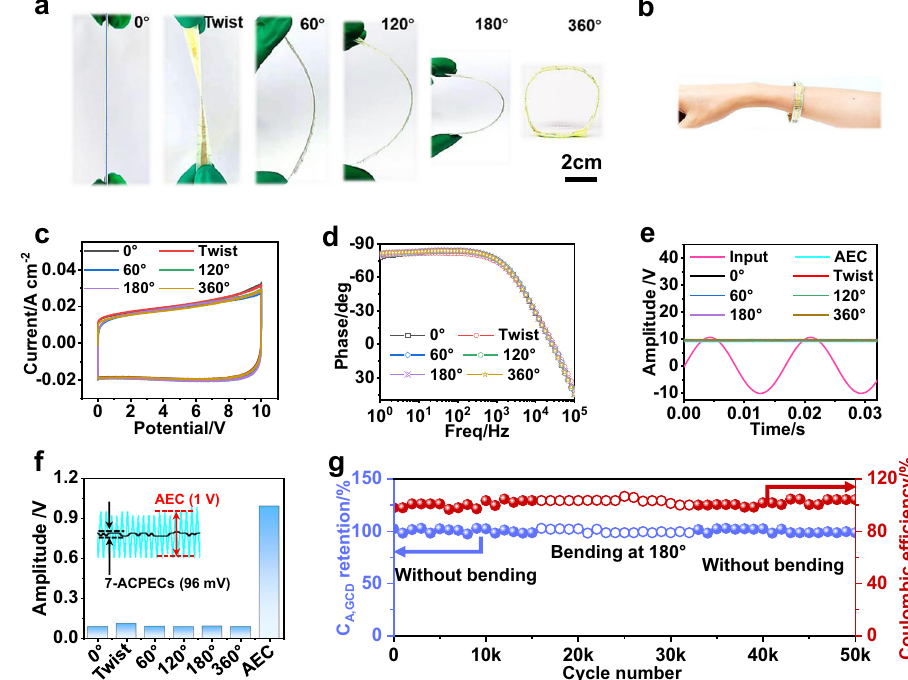
Fig. 4 | The fl exibility and fi ltering performance of 7-ACPECs. a Photos of 7-ACPECstwistedandbentatdifferentangles,suchas,0°,60°,120°,180°and360°, the scale bar is 2cm. b Photo of 7-ACPECs being bent and worn on the wrist like a bracelet. c CV curves of 7-ACPECs under different deformation states (scan rate: 10Vs − 1 ). d Plots of phase angle versus frequency of 7-ACPECs under different deformation states. e The fi ltering performance of 7-ACPECs under different